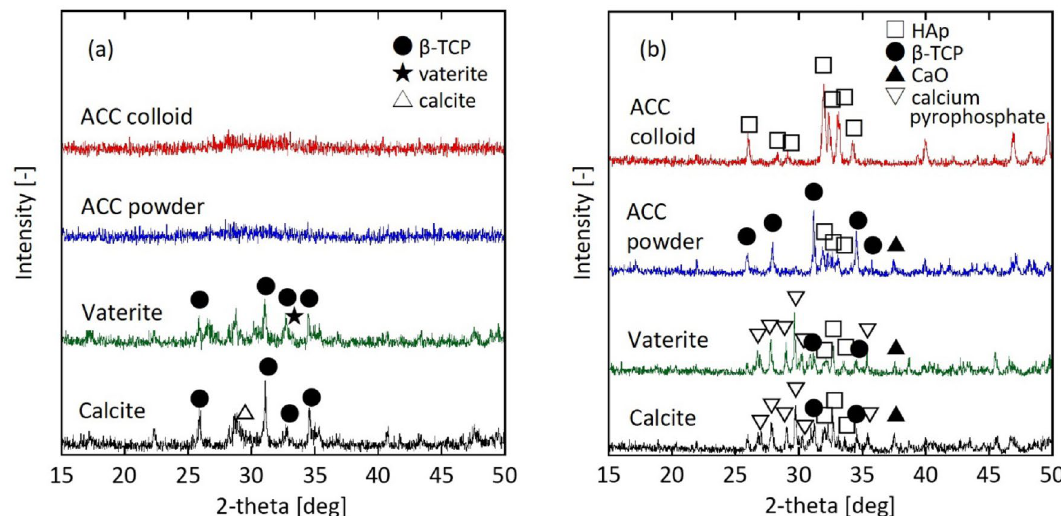
Figure 5. XRD patterns of ( a ) pre-calcined and ( b ) calcined particles. Phosphorylation reaction is performed in a water system using a 1 wt% ACC, vaterite, or calcite powder suspension. Additionally, the reaction with a 1 wt% ACC colloid is also shown. Molar ratio of Ca/P is